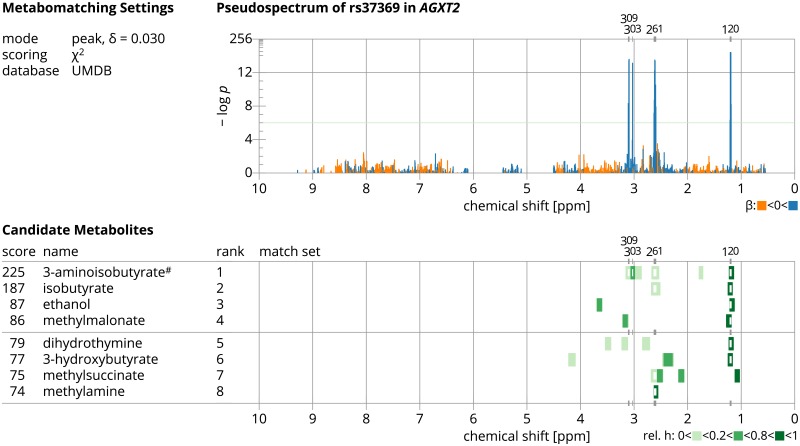
Metabomatching results figure.The metabomatching results figure, shown here for the same AGXT2 pseudospectrum as in Fig 1. The figure shows the metabomatching settings used, the pseudospectrum with features color-coded by effect size, and, for the eight highest ranked candidate metabolites, the score, name, and reference NMR spectrum with match sets color-coded according to the height of the NMR spectrum peak they derive from.